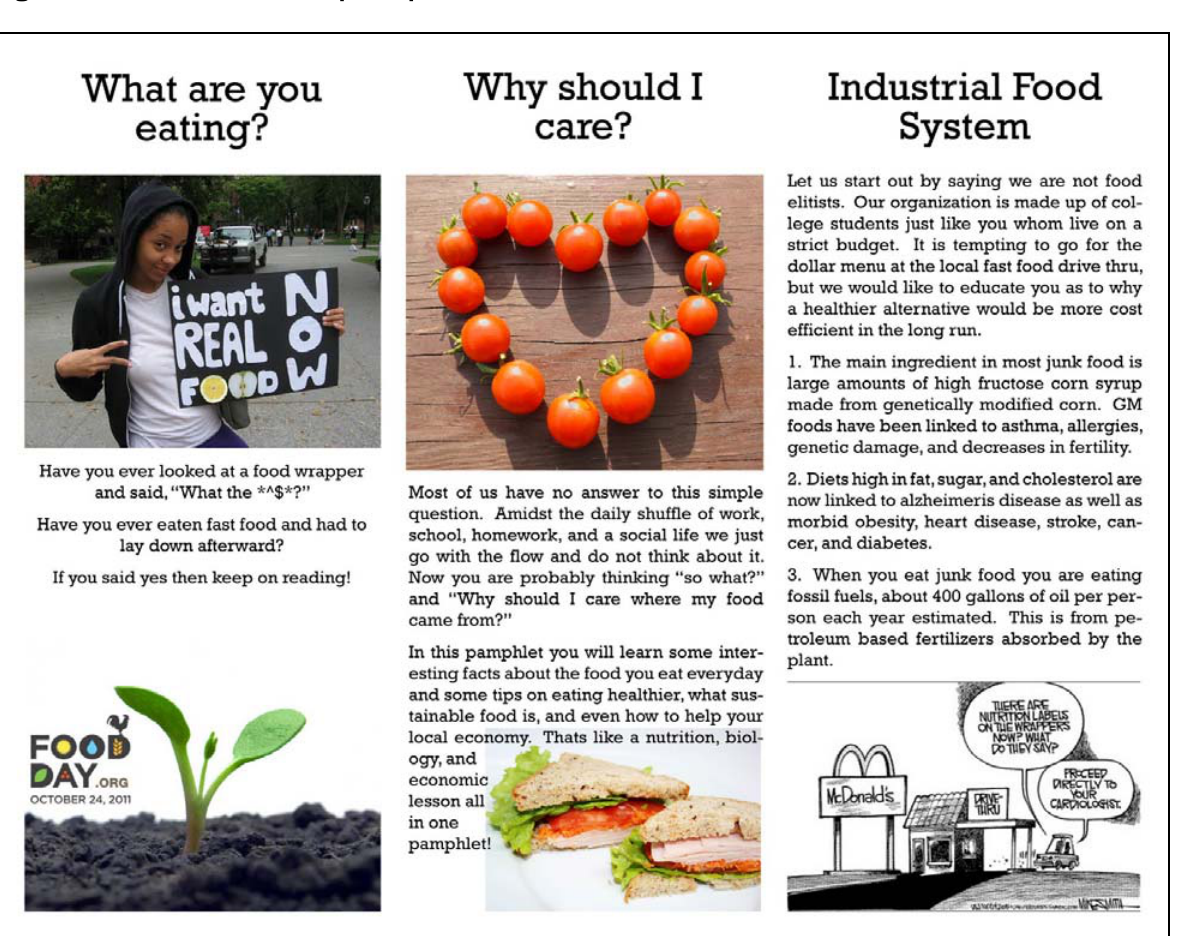
Figure 2. Side One of the Fold-up